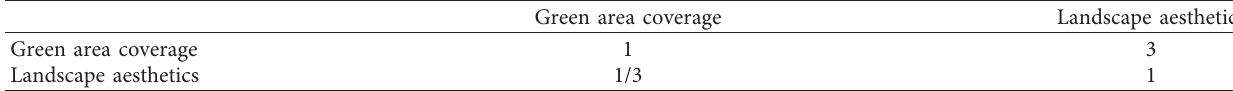
Table 11: Index scale table of the environmental effect plan